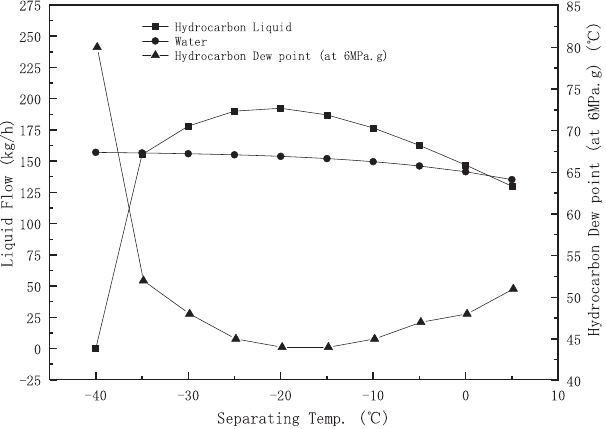
Fig. 3. Variation of heavy hydrocarbon liquid fl ow at different separating temperatures.